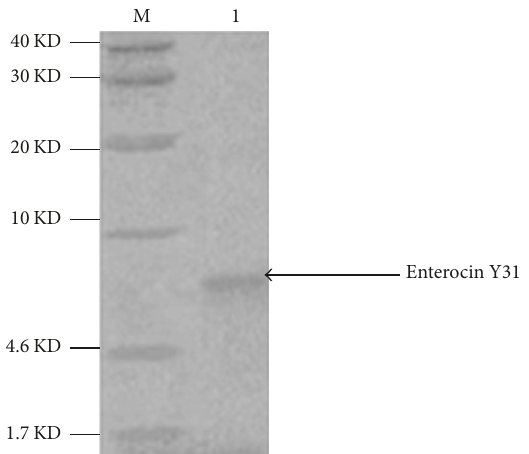
Figure 8: Tricine-SDS-PAGE of Enterocin Y31. M: protein